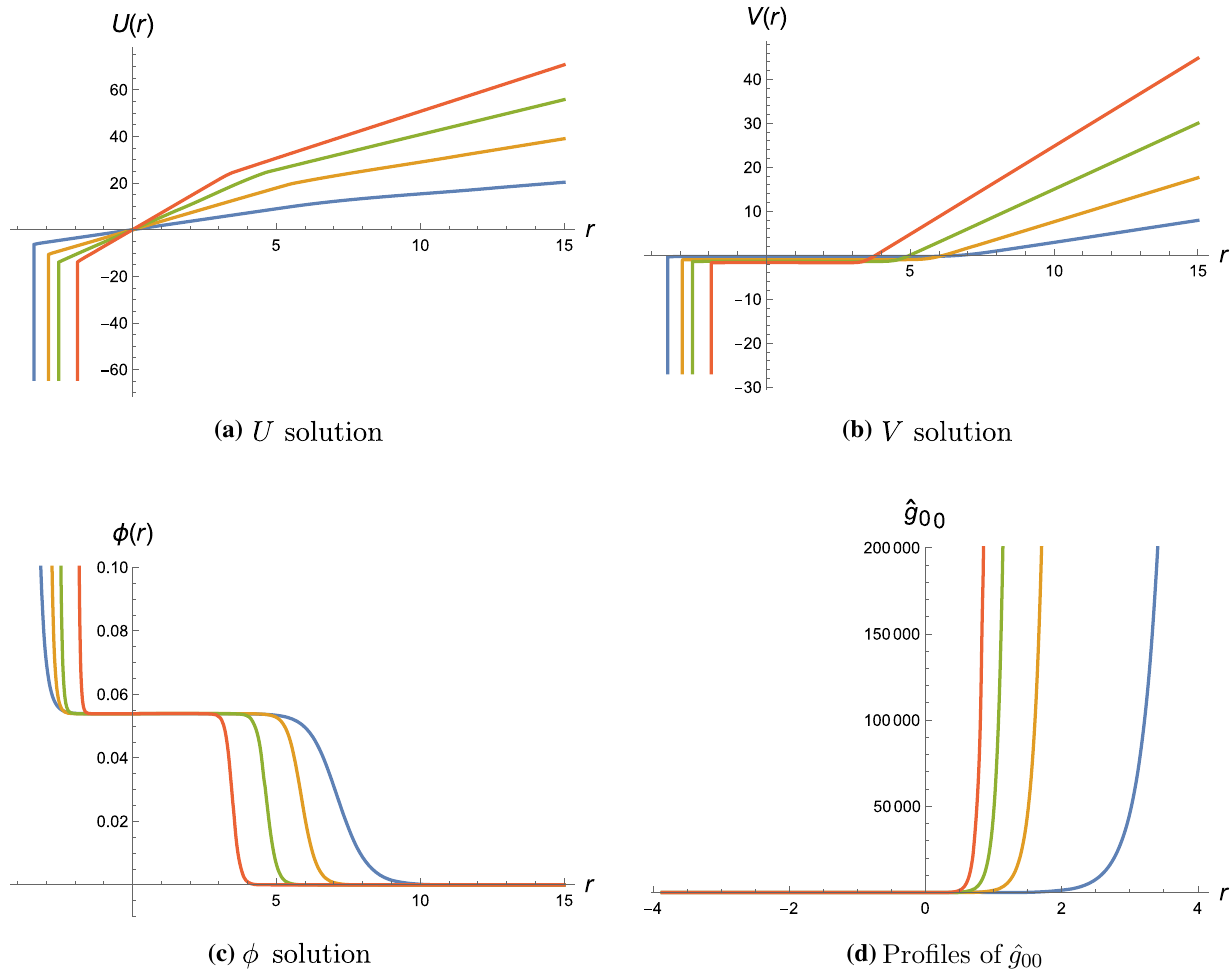
Fig. 24 RG flows from the N = 4 AdS 7 critical point to the AdS 3 × CH 2 fixed point and curved domain walls for SO ( 3 ) + twist in SO ( 5 ) gauge group. The blue, orange, green and red curves refer to g = 8 , 16 , 24 , 32,